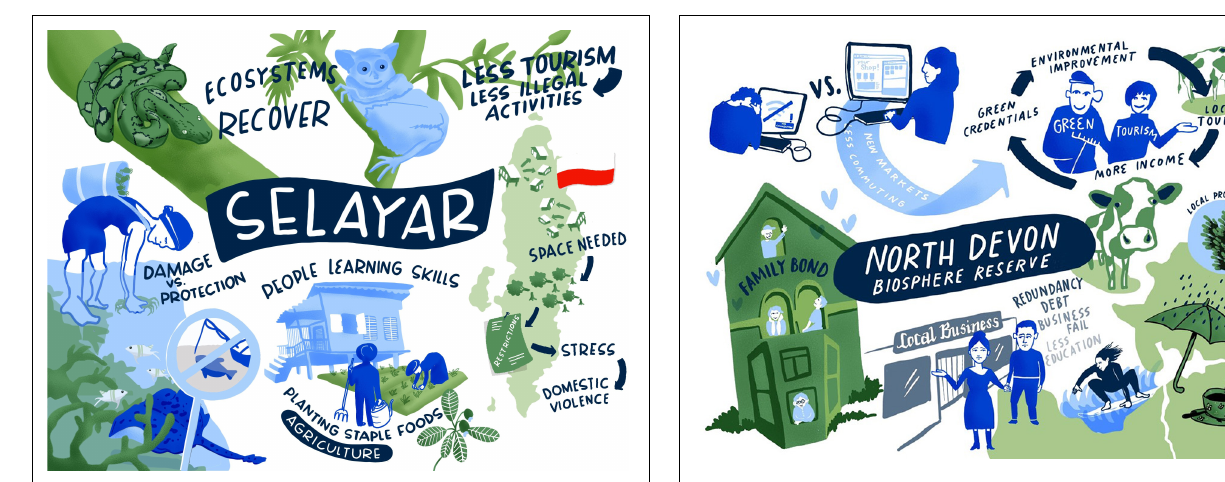
COVID-19 scenario for North Devon Biosphere Reserve